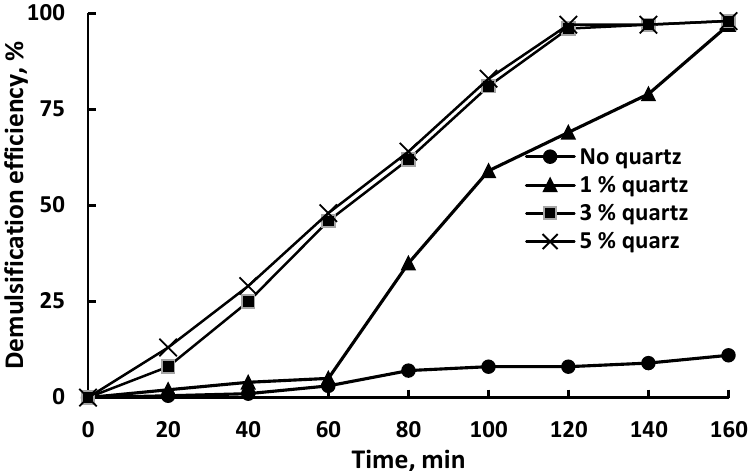
Figure 5. Demulsification efficiency of the untreated quartz particles with a mesh size of 75 μm.